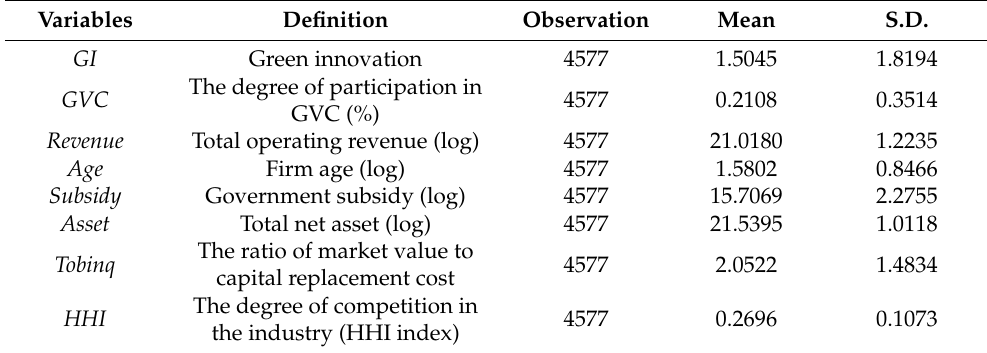
Table 1. Descriptive